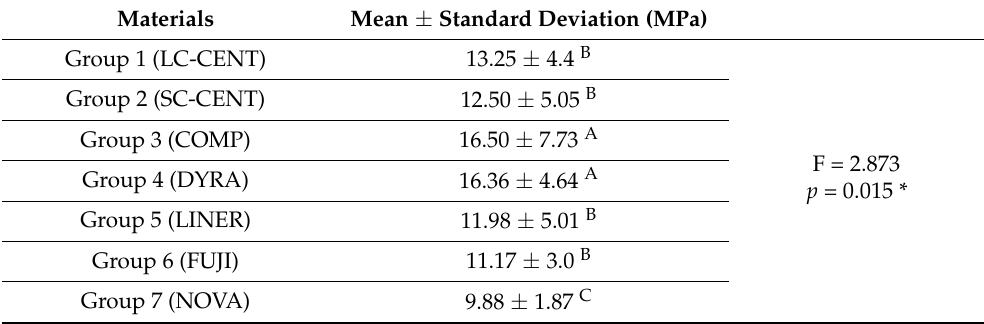
Table 3. The microtensile bond strength ( µ TBS) values for each dental restorative material with teeth.